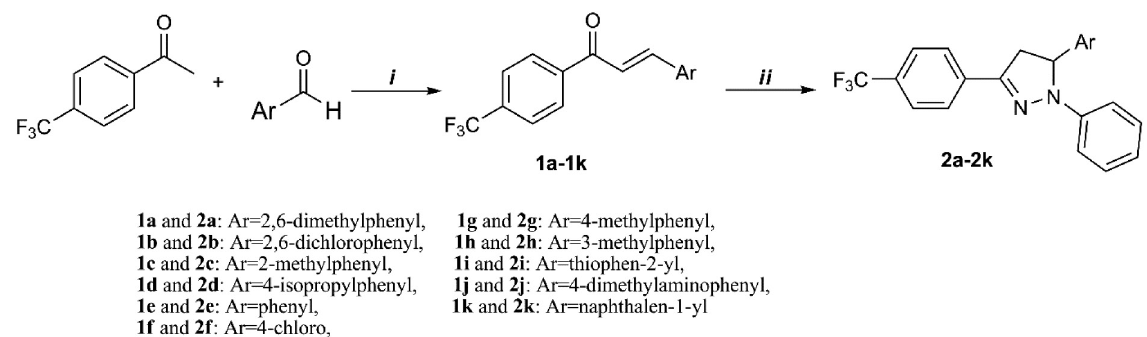
Figure 2. The synthetic pathway for compounds 1a-1k and 2a-2k . Reagents and conditions: ( i ) methanol, NaOH, 10 h; ( ii ) phenylhydrazine hydro- chloride, acetic acid, reflux, 12